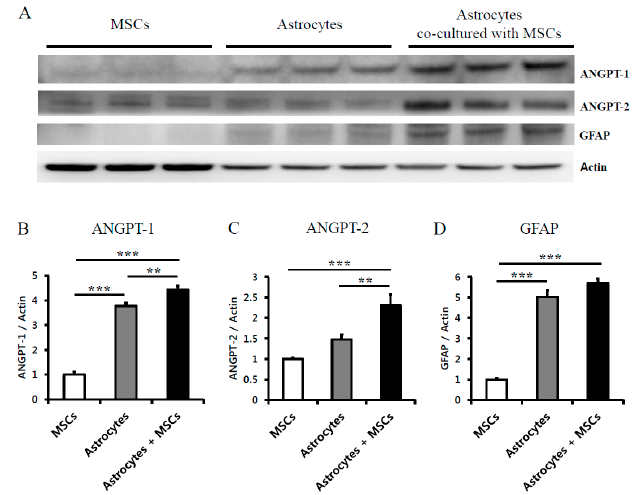
Figure 5. Stimulated astrocytes by MSCs released angiogenic factors: ( A ) representative images of Western blot analysis; ( B , C ) when astrocytes co-cultured with MSCs were cultured, angiogenic factors, such as ANGPT1 and ANGPT2, were significantly increased compared to cultured astrocytes alone and cultured MSCs alone (** p < 0.01 and *** p < 0.001, respectively, n = 3 each); and ( D ) the astrocytes co-cultured with MSCs and astrocytes cultured alone increased the expression of GFAP compared with MSCs groups (*** p < 0.001, n = 3 each). Values represent mean + SEM.